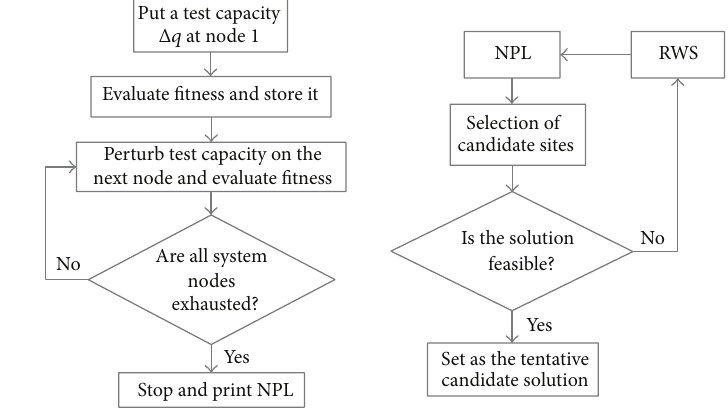
Figure 3: Intelligent search.